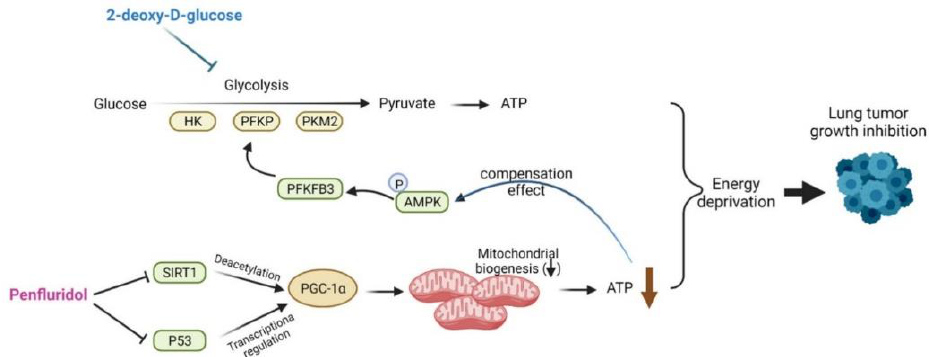
Figure 6. A working model showing the molecular mechanisms underlying the ability of penfluridol to modulate energy metabolism of human non-small cell lung cancer (NSCLC) cells. ATP deprivation induced by penfluridol was attributed to inhibition of mitochondrial oxidative phosphorylation (OXPHOS) via inducing loss of the mitochondrial membrane potential (MMP) and a decrease in mitochondrial biogenesis. The sirtuin 1 (SIRT1)/peroxisome-proliferator-activated receptor co-activator-1 α (PGC-1 α ) axis is critical for penfluridol-regulated mitochondrial biogenesis. Meanwhile, penfluridol also induced adenosine monophosphate-activated protein kinase (AMPK)-mediated glycolysis to compensate for the loss of ATP caused by mitochondrial OXPHOS suppression. A combination of the glycolysis inhibitor, 2DG, and penfluridol further enhanced the anticancer potential of this repurposed drug in NSCLC